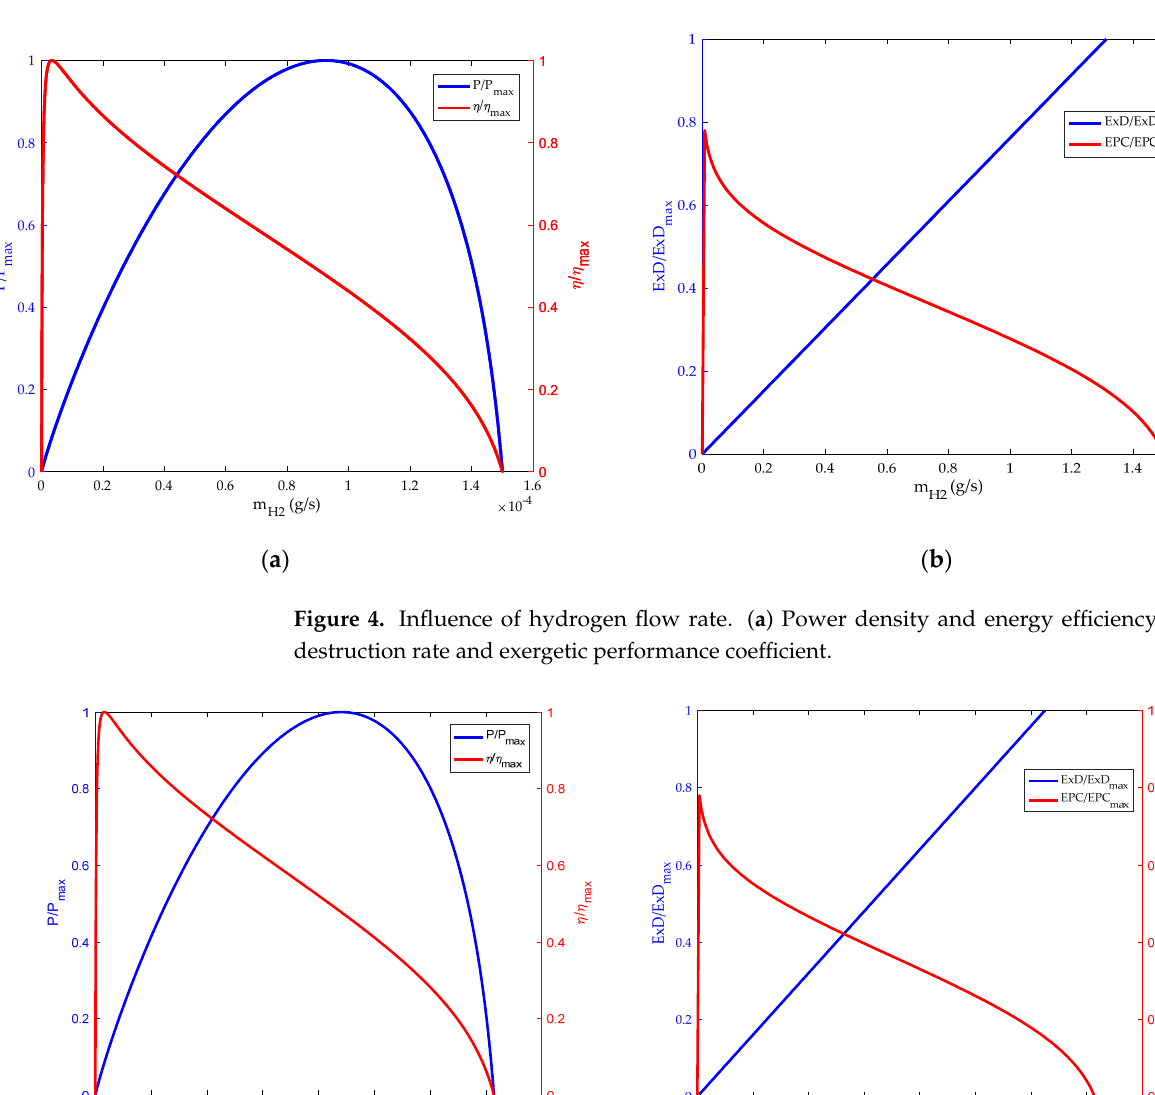
( b ) Figure 6. Influence of doping level. ( a ) Power density and energy efficiency; ( b ) exergy destruction rate and exergetic performance coefficient.